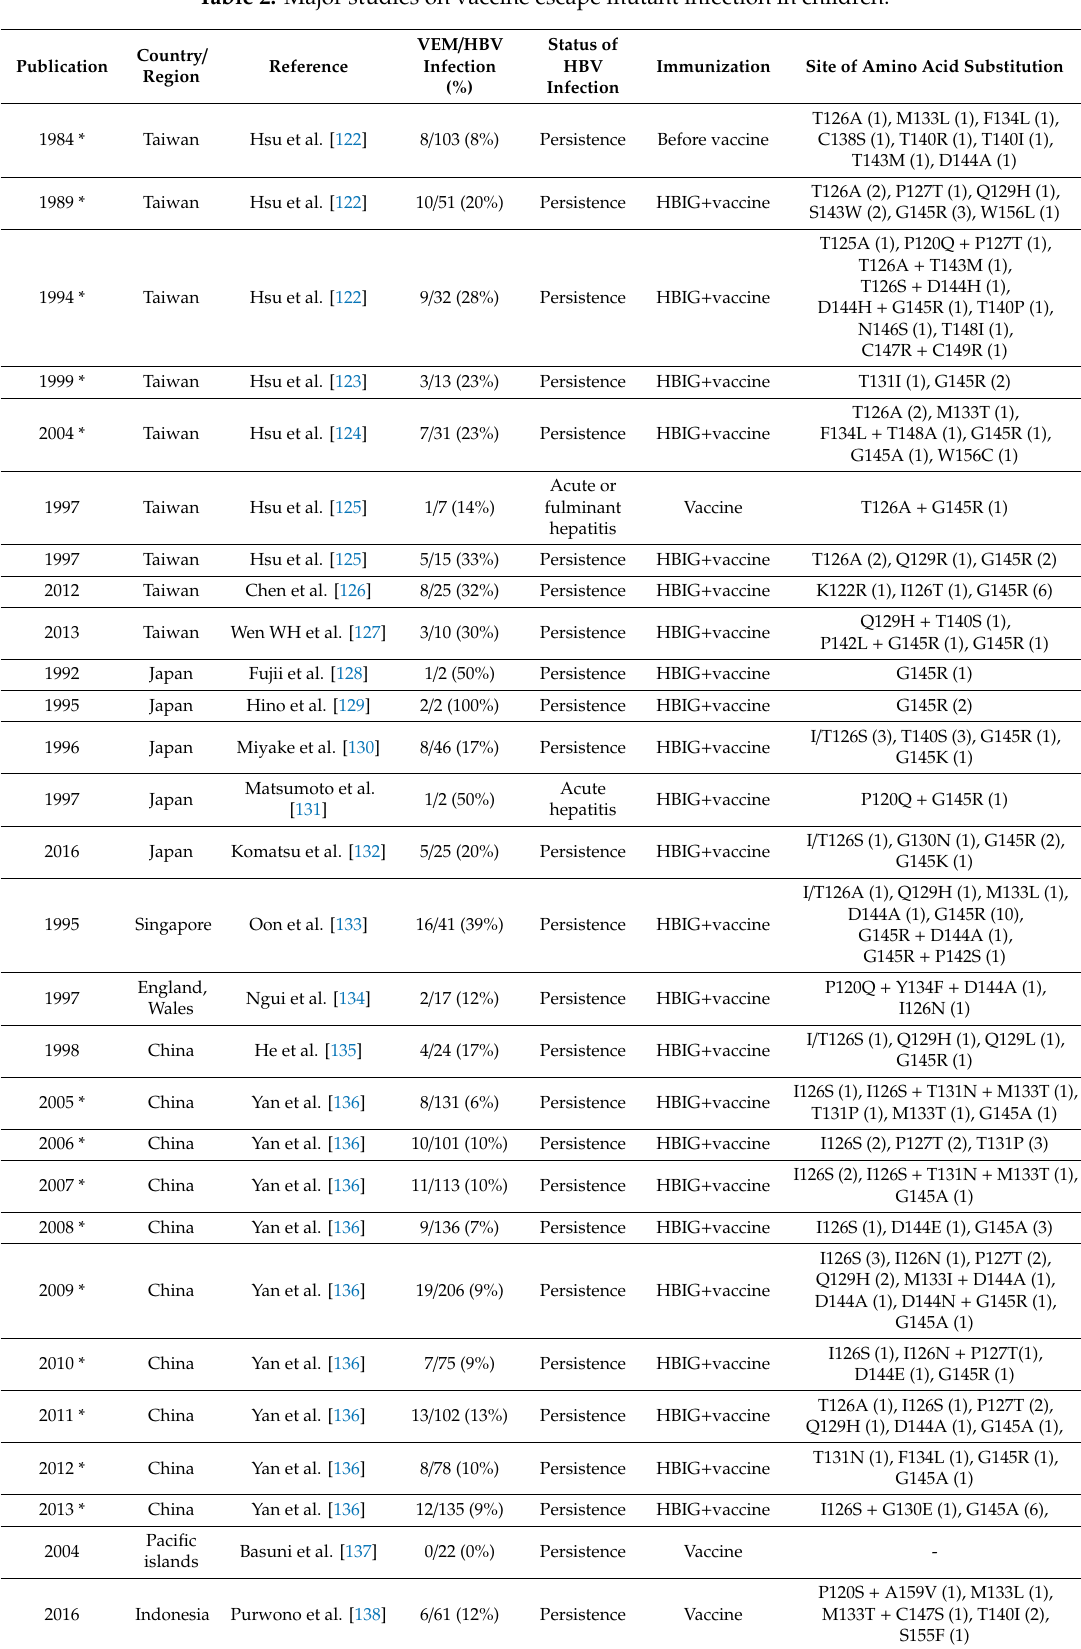
Table 2. Major studies on vaccine escape mutant infection in